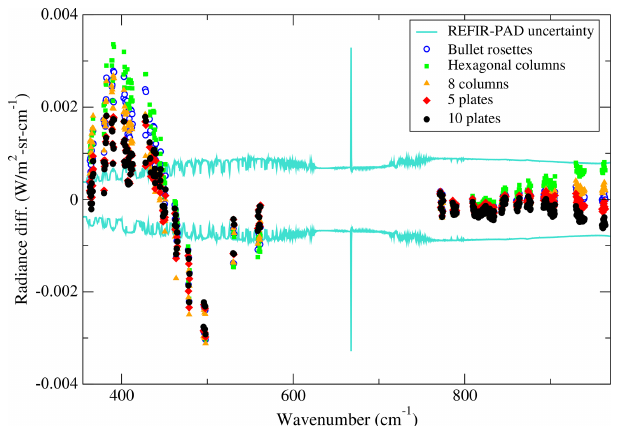
Figure 9. Comparison with respect of the averaged REFIR-PAD in- strumental uncertainty (turquoise curves) of the mean differences between the measurements and the simulated spectra calculated in 28 selected microwindows reported in (Turner et al., 2003) for var- ious ice crystal